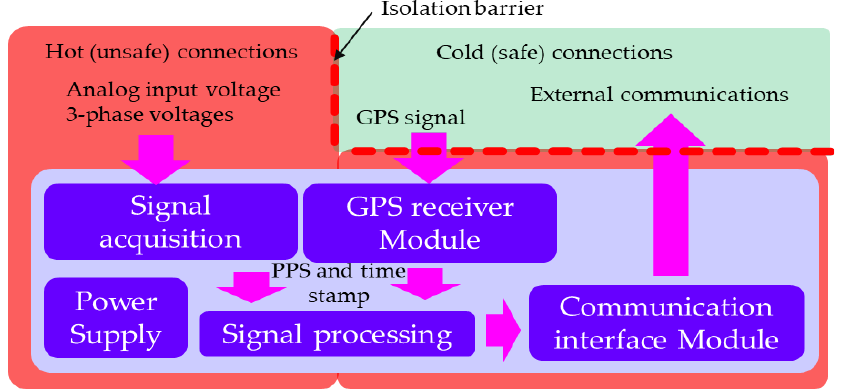
Figure 9. Block diagram of proposed PMU indicating the location of the isolation barrier.